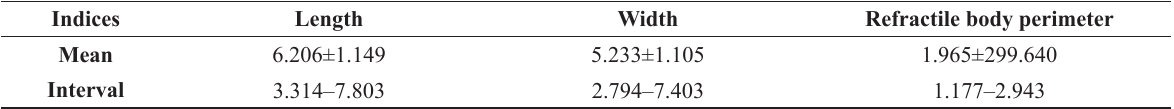
Measurements (μm) of the spores of Dermocystidium sp. (n = 53) collected in the gills of Oreochromis niloticus , cultivated in Santa Catarina, southern Brazil. (Mean ± standard